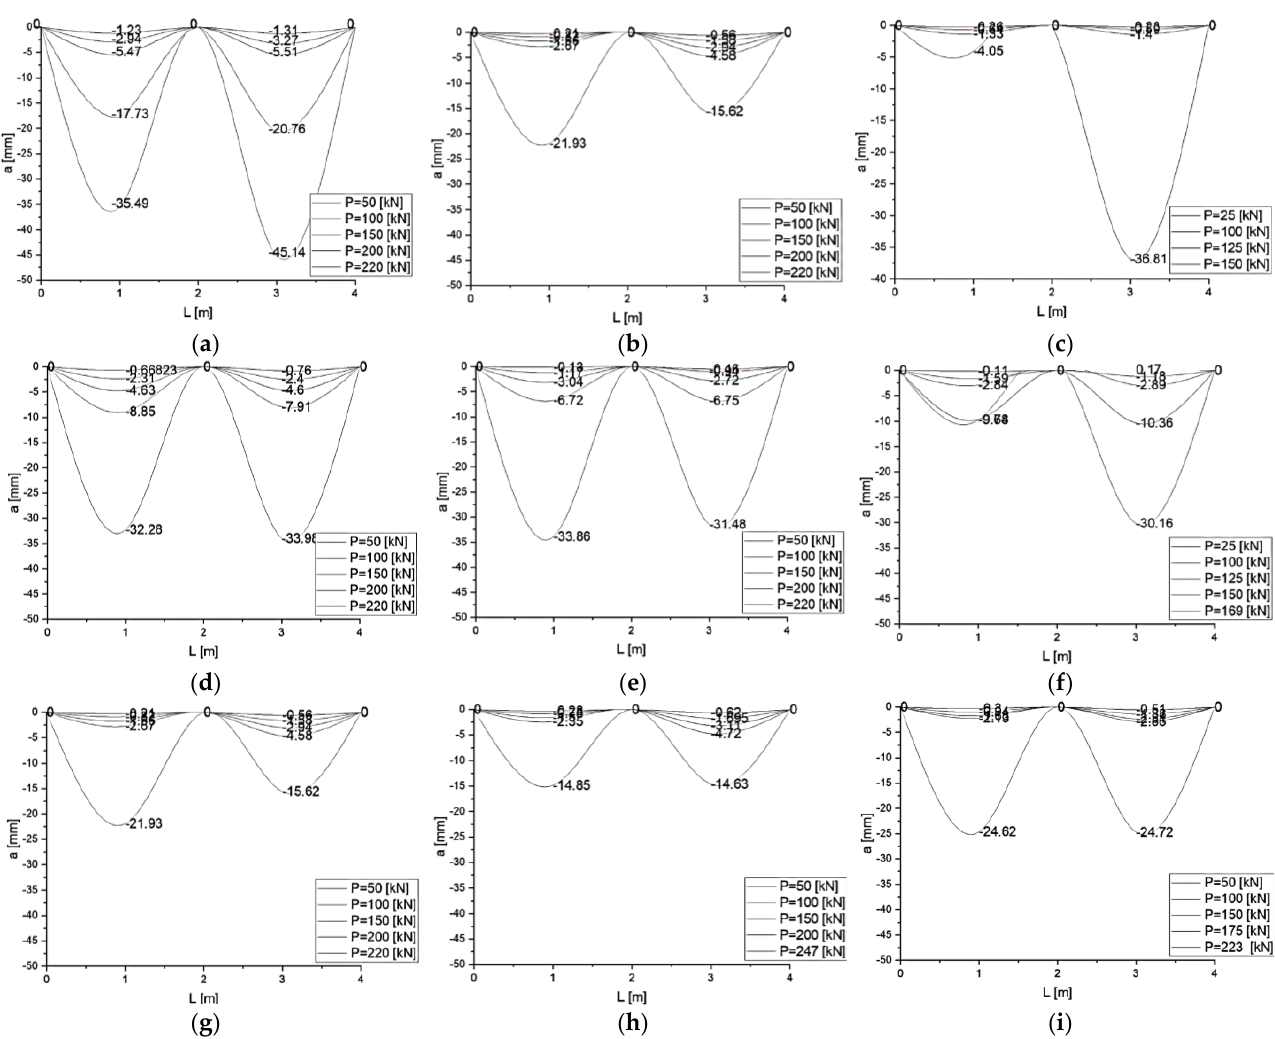
Figure 5. Relationships between force P [kN] and mean deflection a [mm] in the spans of series: ( a ) C-I-W0; ( b ) C-II-W0; 259 ( c ) C-III-W0; ( d ) C-I- WS78.5; ( e ) C-II- WS78.5; ( f ) C-III- WS78.5; ( g ) C-I-WB5; ( h ) C-II- WB5; ( i ) C-III-WB5.